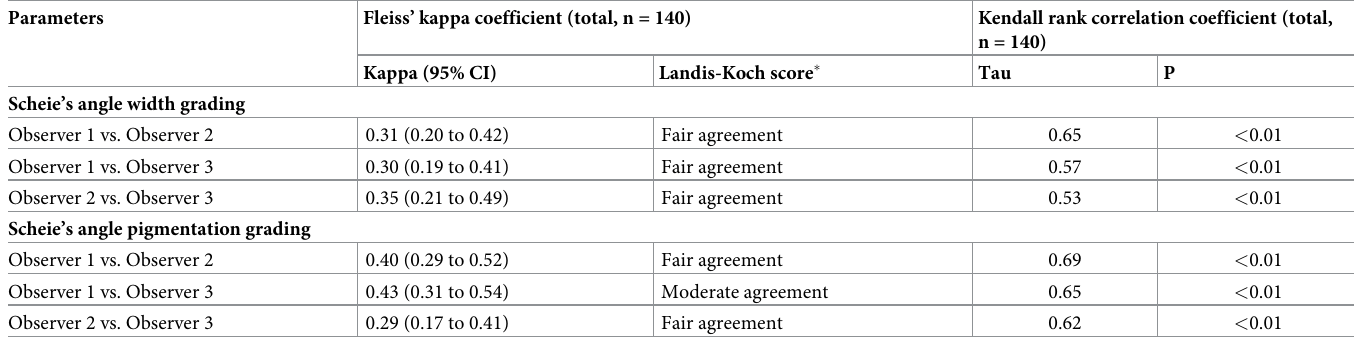
Table 6. Inter-observer reproducibility analyses for angle gradings by glaucoma specialists using gonioscopic photos of